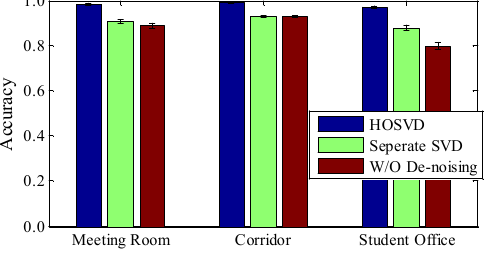
Figure 13. Impact of image de-noising.